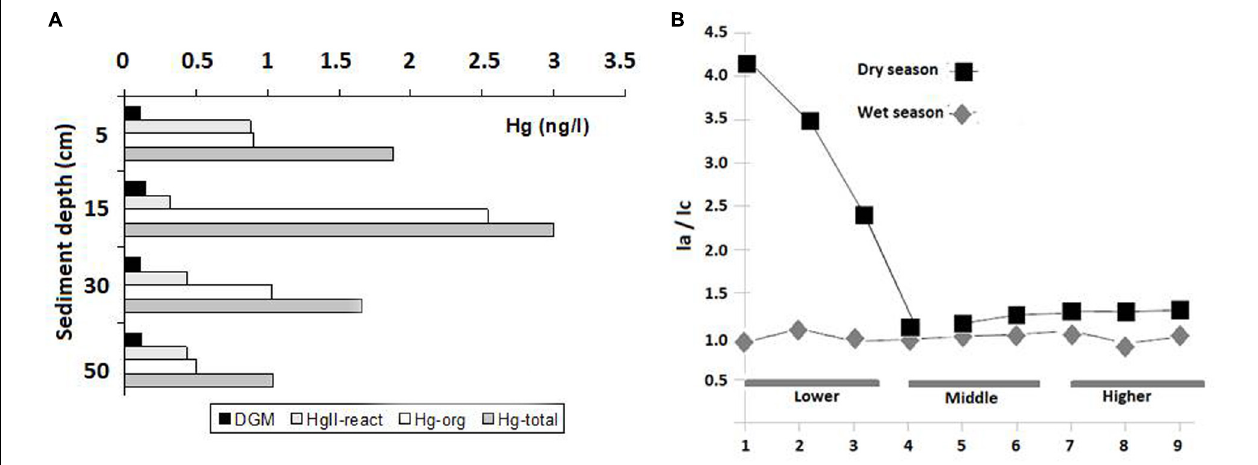
FIGURE 1 | Changes in DOC fluorescence along the estuarine gradient of the Jaguaribe River. (A) Hg speciation in pore waters in a mangrove-dominated area showing increasing organic matter-Hg complex production, adapted from Mounier et al. (2001) and Marins et al. (1997). (B) Ia/Ic ratio matrices according to Coble (1996) and adapted from Mounier et al.